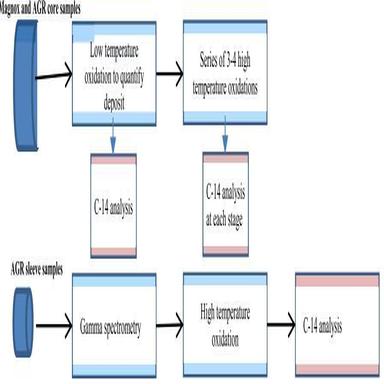
Flow diagrams for the oxidation and analysis procedure for the Magnox and AGR core samples and for the AGR sleeve samples.